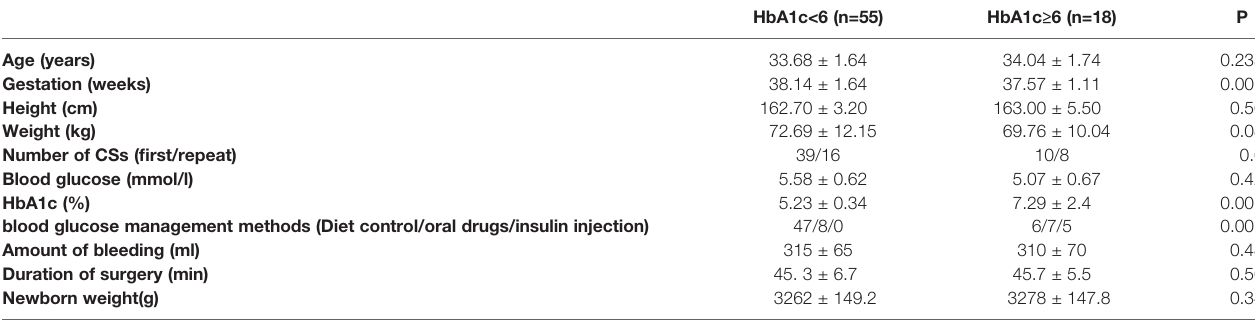
Data are presented as the mean ± SD or